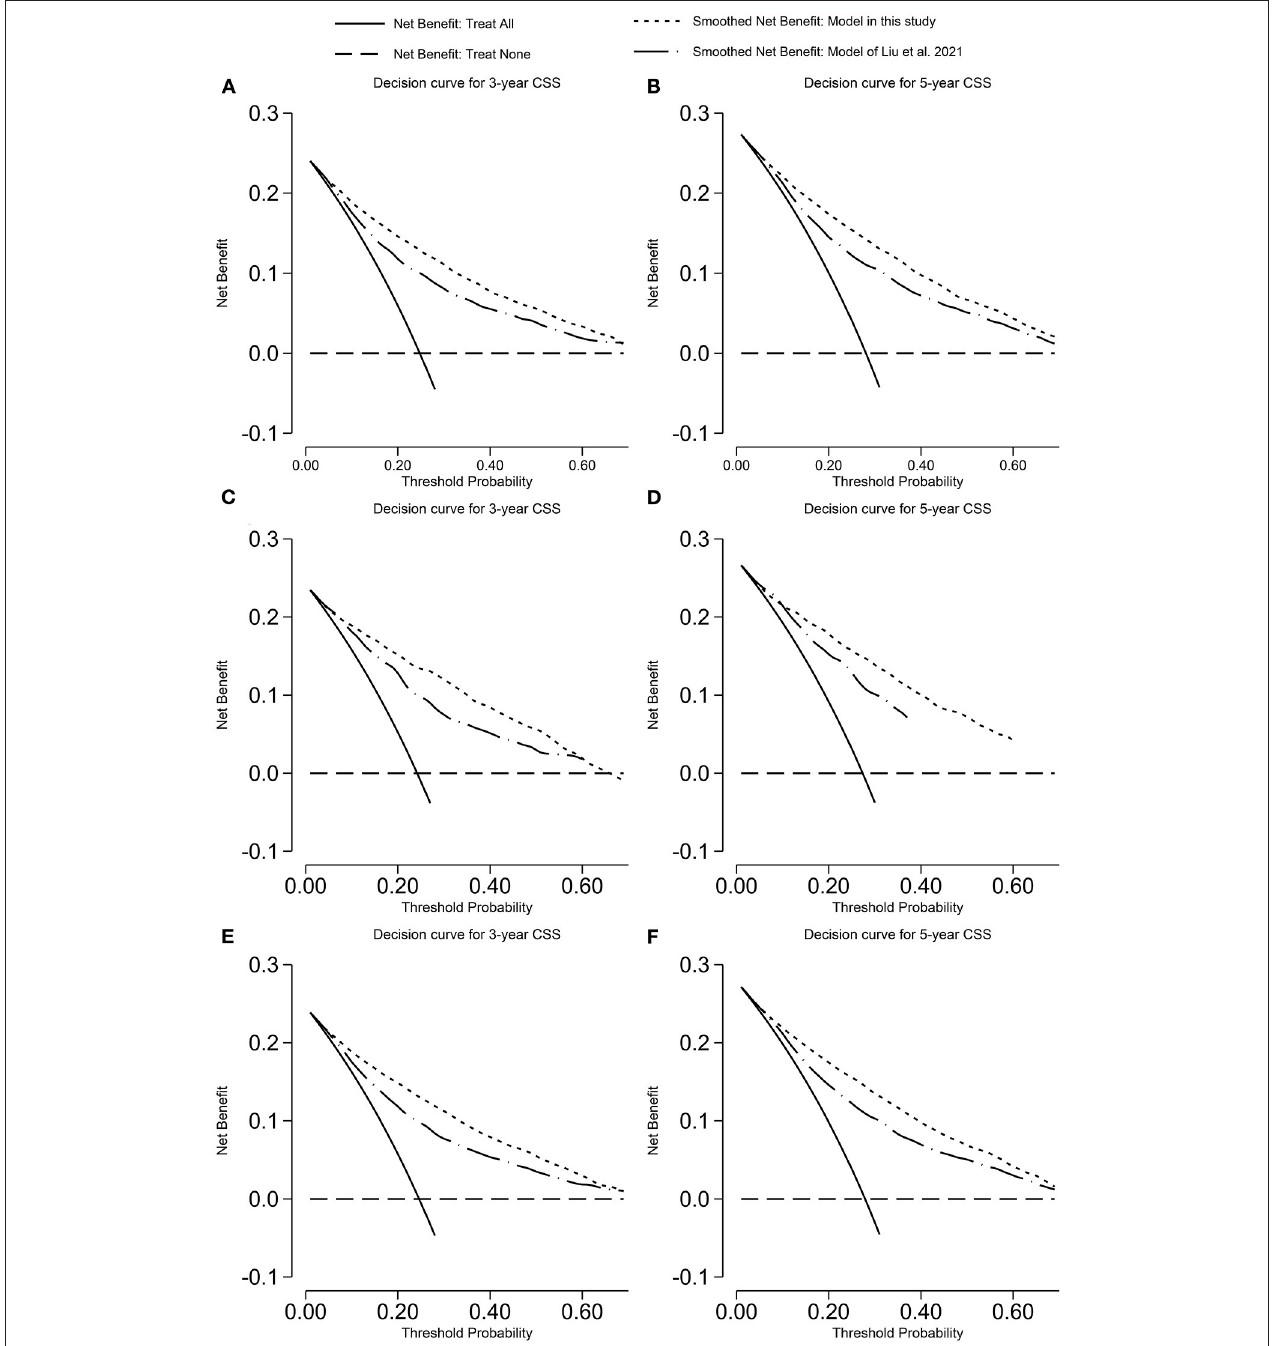
FIGURE 3 | Decision curve analysis on the model predicting CSS. (A) 3-years CSS in the training cohort; (B) 5-years CSS in the training cohort; (C) 3-years CSS in the validation cohort; (D) 5-years CSS in the validation cohort; (E) 3-years CSS in the overall cohort; and (F) 5-years CSS in the overall cohort. CSS, cancer-specific